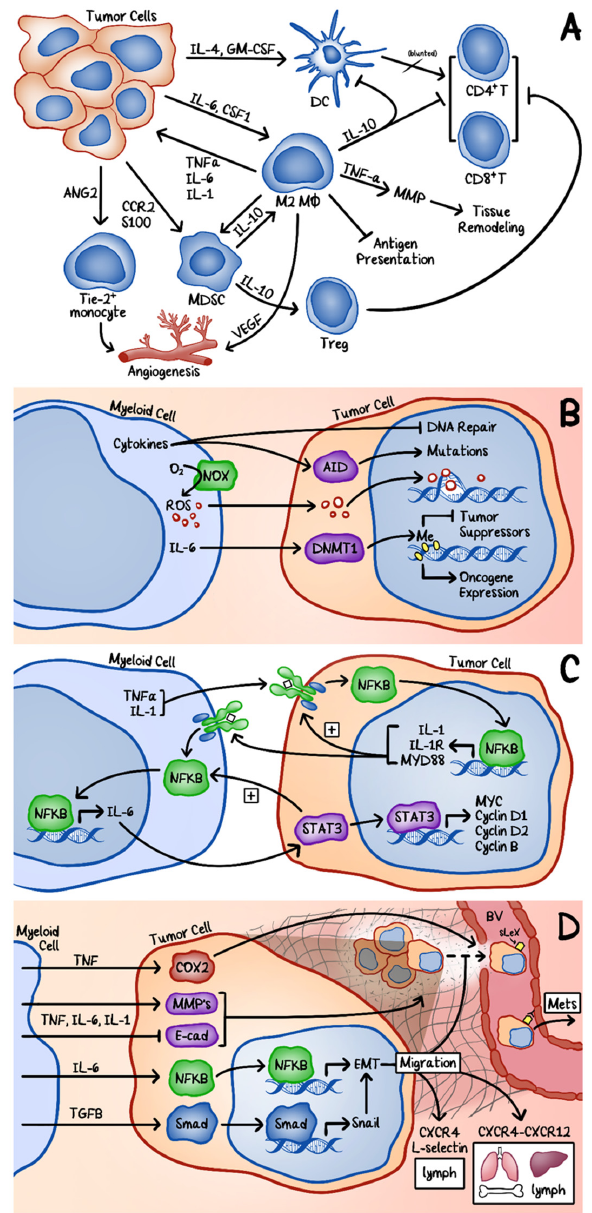
Figure 4. The interplays between tumor cells and inflammatory cells during tumorigenesis. (A ) The effect of tumor cells on inflammatory cells. Tumor cells secrete many cytokines to alter the microenvironment to promote tumor growth and invasion and to blunt the anti-tumorigenic immune response. (B ) Inflammatory cells affect the genomic stability of tumor cells. AID: activation-induced cytidine deaminase; DNMT1: DNA methyltransferase 1. (C ) Inflammatory cells enhance tumor cell proliferation and survival through autocrine and paracrine signaling. (D ) Inflammatory cells promote tumor cell migration, invasion, and metastasis through cytokine and chemokine production. COX-2: cyclooxygenase 2; MMP: matrix metalloproteinase; E-cad: E-cadherin; EMT: epithelial-mesenchymal transition; sLex: sialyl Lewis X; CXCR: CXC chemokine receptor; BV: blood vessel. The key inflammatory mediators for tumor proliferation and survival include NF- κ B and signal transducer and activator of transcription 3 (STAT3) (Figure 4C) [52]. IL-6, secreted by the myeloid